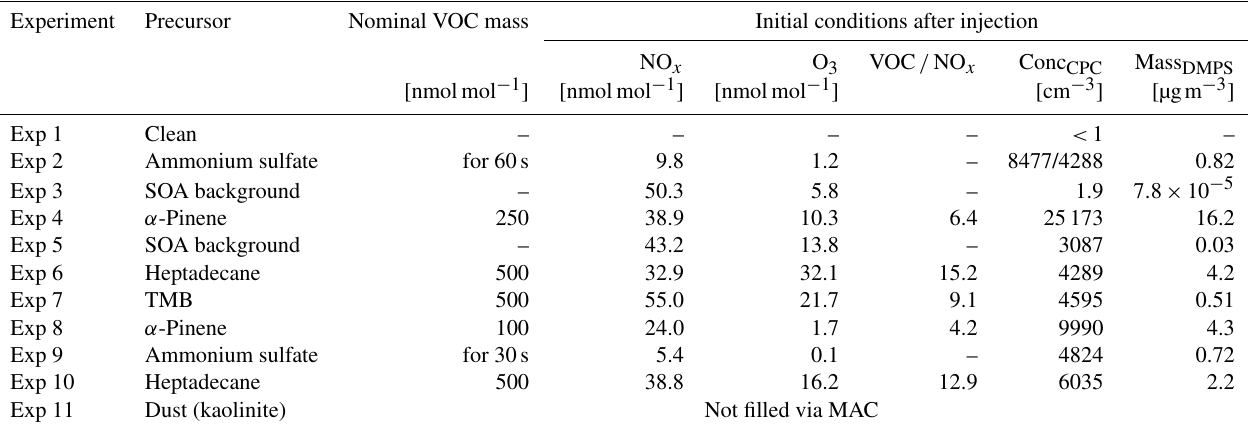
Figure 2. Composition and bounced fraction of SOA particles in MAC. Open symbols represent data collected in experiments where there was no quantitative ice nucleation data. Panel (a) shows the mass fraction of the aerosol mass spectrometer (AMS) fragments measured at m/z =44 throughout their growth in the aerosol chamber. Panel (b) shows bounced fractions for heptadecane, α -pinene and limonene, and limonene experiments as a function of RH at the latest available time before transfer. In general higher bounce fractions are found at lower relative humidity. It can clearly be seen that SOA from the heptadecane experiment exhibit very different behaviour, maintaining a bounced fraction of less than 0.012 even at the lowest available RH. All other bounced fraction data are similar to the other examples shown. The heptadecane experiment also shows a much lower m/z =44 fraction than in other experiments. Table 2. Initial nominal conditions for SOA formation in the aerosol chamber. For a description of how the VOCs are injected into the chamber see Sect.